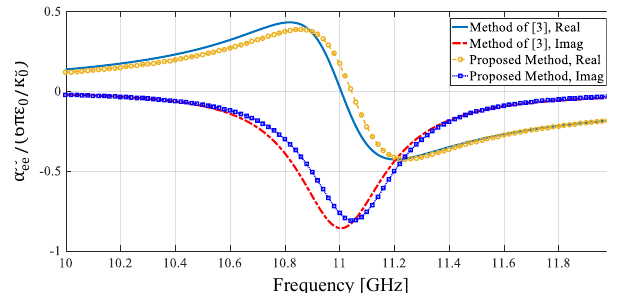
Figure 5: Real and imaginary parts of normalized y directed electric polarizability of electric resonance particle. The results are compared with the method explained in [3], reviewed in Appendix